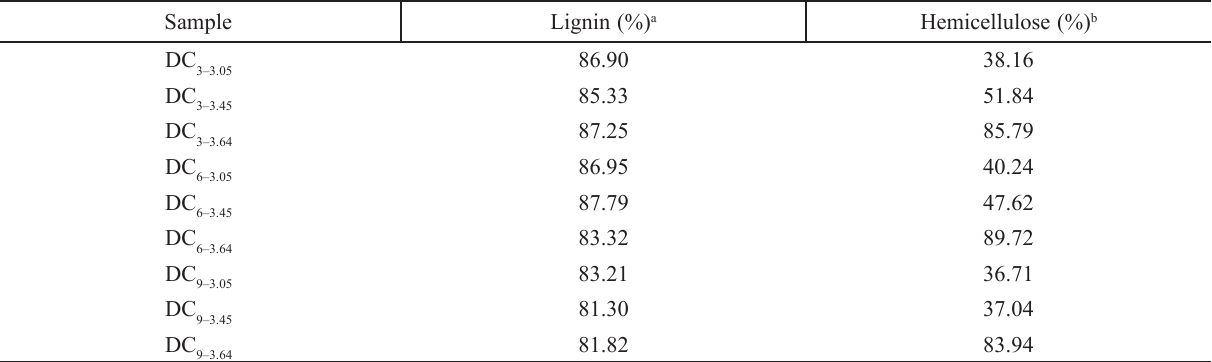
Table S1 – Percentage of removed lignin and hemicelluloses in corncob after simultaneous steam explosion and alkaline depolym - erization